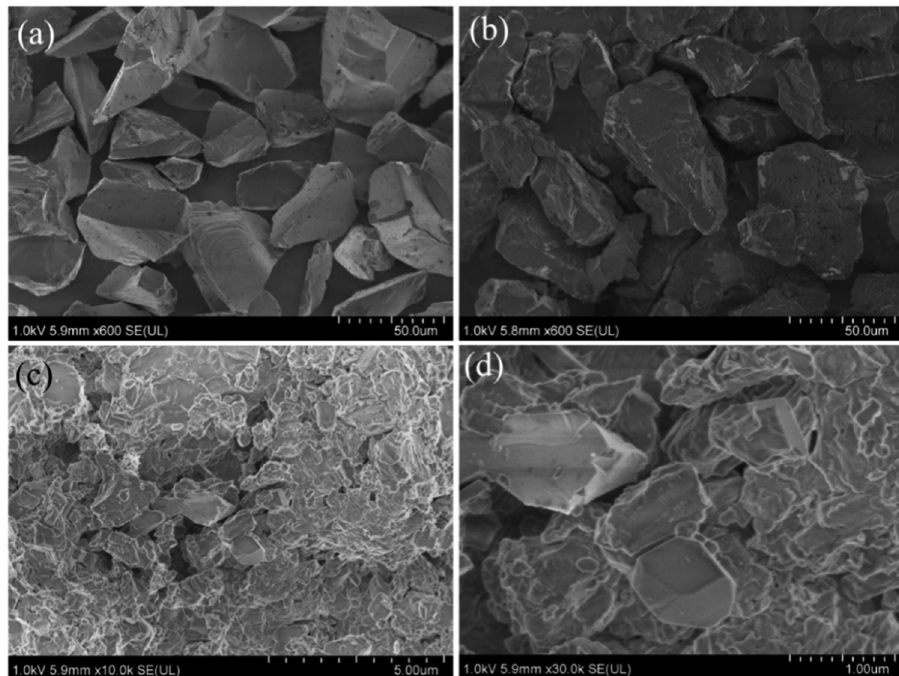
Figure 3: SEM images of ( a ) SiC; ( b ) SiC - KH560; ( c and d ) SiC - M with di ff erent ampli fi cation ratios.